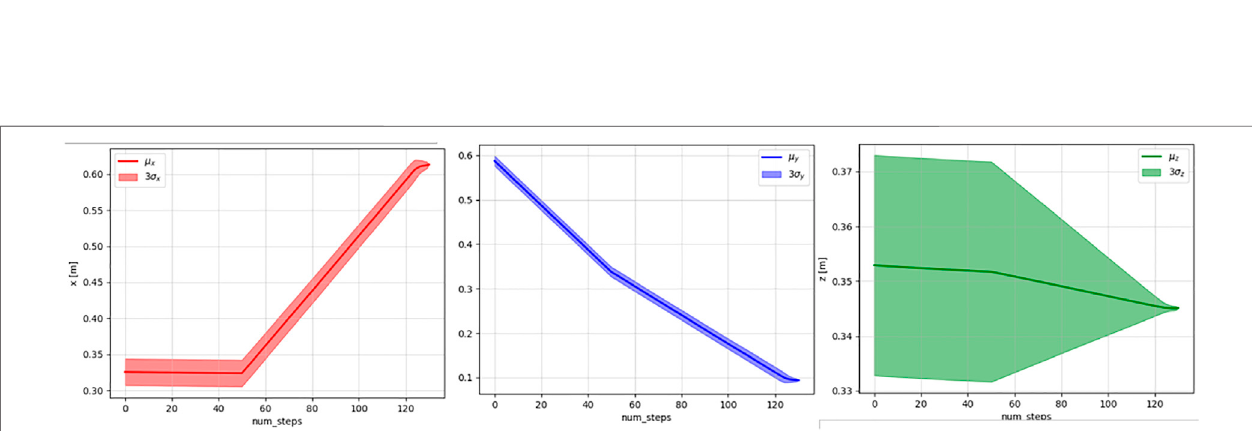
FIGURE 3 | Means and three standard deviations of the x (left), y (middle), and z (right) values of the demonstrated trajectories.